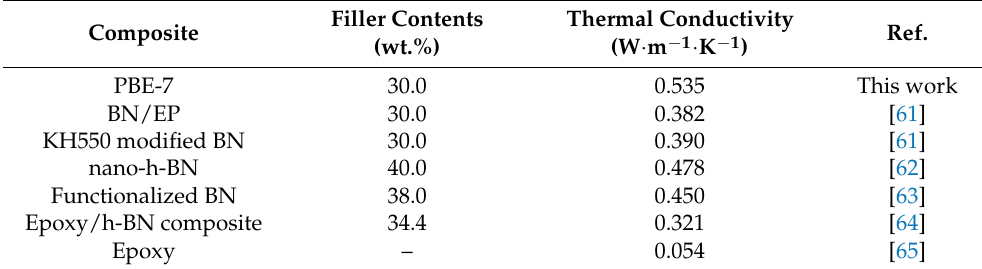
Table 1. Comparison of various BN/epoxy composites.